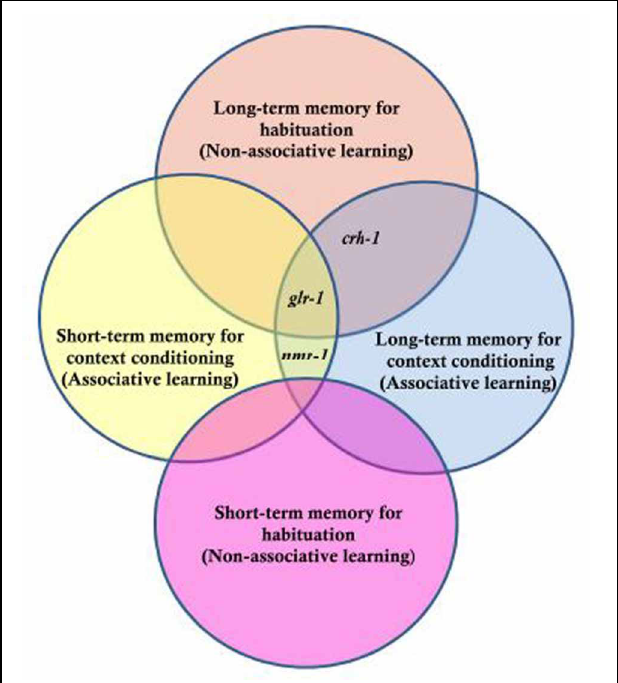
FIGURE 5 | Genes tested for their role in long- and short-term memory for non-associative habituation and associative context conditioning. Three genes were tested, crh-1 which is the worm homologue of CREB, glr-1 the worm homologue of a glutamate AMPA-type receptor subunit and nmr-1 the worm homologue of an NMDA-type glutamate receptor subunit. The results indicated that nmr-1 is required for short and long-term context conditioning but not necessary for non-associative learning; crh-1 is critical for long-term but not short-term memory for both associative and non-associative memory and that glr-1 is not required for short-term non-associative learning, but required for long term as well as short- and long-term context conditioning [Based on data from Lau et al.